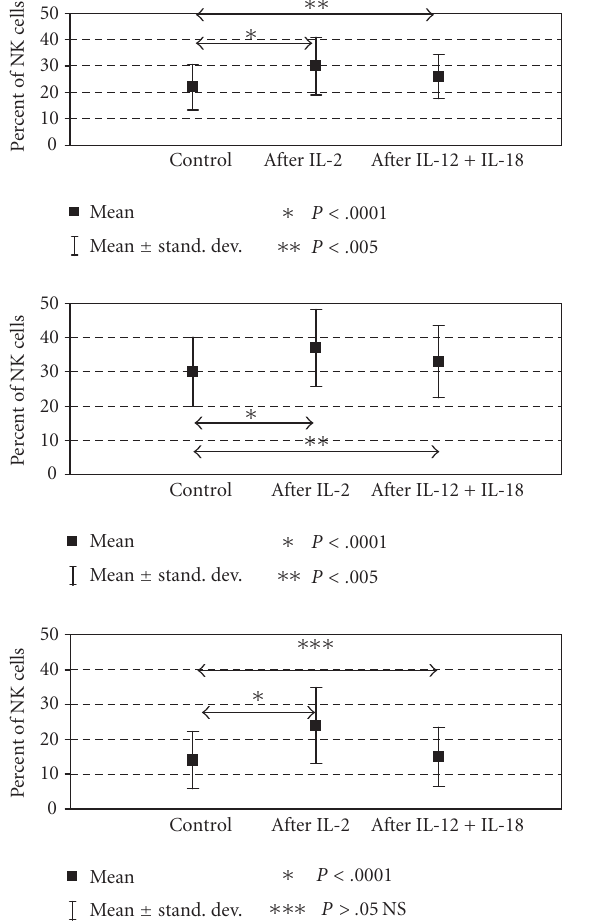
Figure 2: Intensity of fluorescence: estimation of the number of re- ceptors KIR2DL1, KIR2DL2, and KIR3DL2 on the surface of NK cells. Both IL-2 and IL-12 + IL-18 caused significant increase in the number of the KIR2DL1 and KIR2DL2 receptors on NK cells. Neither IL-2, nor a mixture of cytokines IL-12 + IL-18, a ff ected the number of the KIR3DL2 receptors. ∗ denotes P < . 005; ∗∗ denotes NS